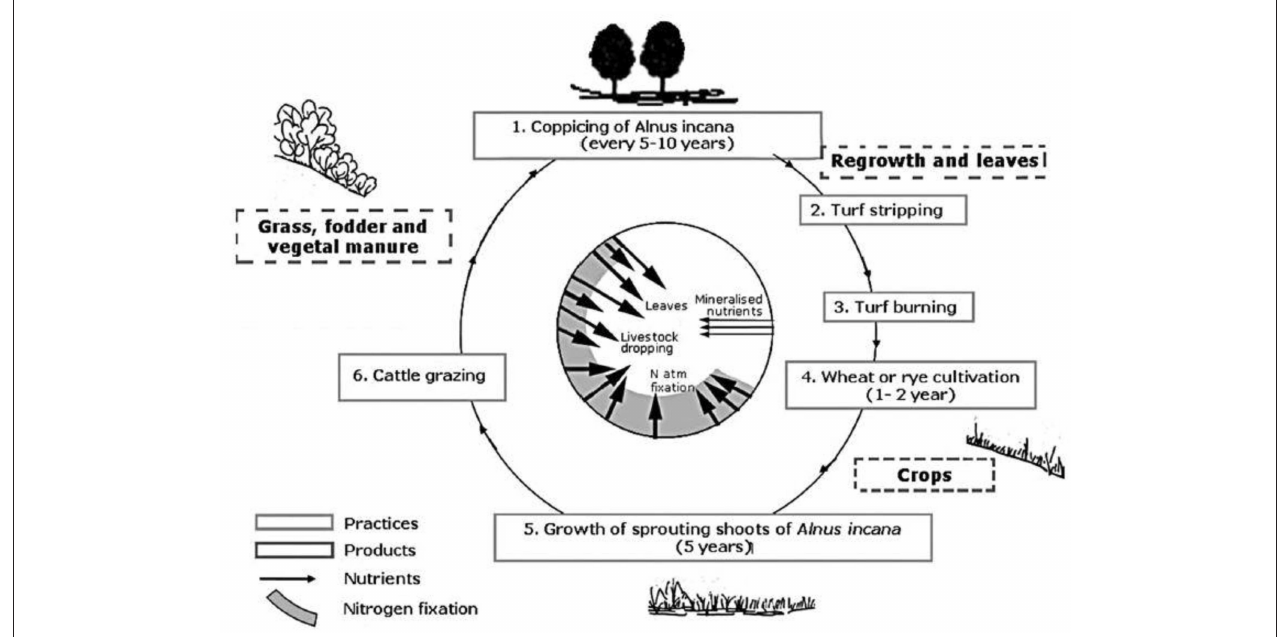
FIGURE 2 | The alnocoltura cycle. Economic products (outer circle, dashed boxes), management practices (outer circle, solid boxes), and nutrient sources (inner circle). After Moreno et al. (1998) in Molinari and Montanari (2016, p. 32).